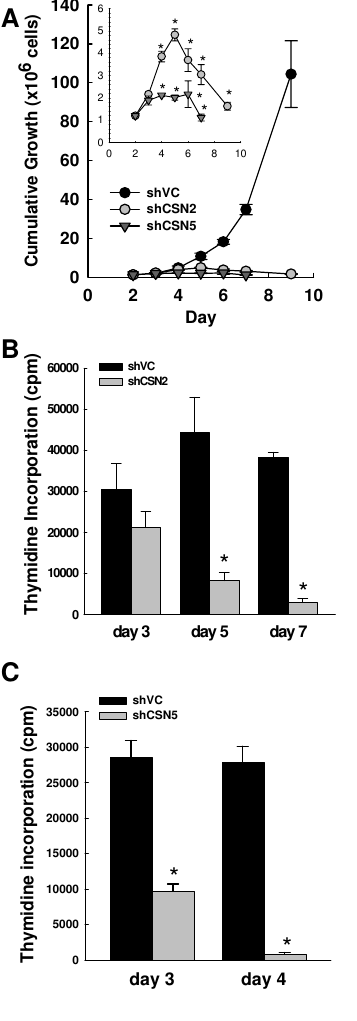
Figure 3 Both CSN2 and CSN5 knockdowns result in reduced cell growth . K562 cells were transiently co-transfected with HKK plasmid together with either shVC, shCSN2 or shCSN5 plasmid. HKK positive cells were sorted 24 hours post-transfection and cells re-cultured. (A) Cell counts were taken daily and the cumulative growth calculated. The cumu- lative growth of shCSN2 and shCSN5 cells is shown relative to shVC. The insert graph has a different Y scale to highlight the differences between shCSN2 and shCSN5 cumulative growth profiles. Data shown are the mean ± s.e.m. of n = 3. * indicates a significant difference to shVC cell growth with a p value of less than 0.05. (B) Thymidine incorporation in shCSN2 cells relative to shVC cells was measured day 3, 5 and 7 post transfection. Data shown are the mean ± s.e.m. of n = 3. (C) Thymidine incorporation in shCSN5 cells relative to shVC cells was measured day 3 and 4 post transfection. Data shown are the mean ± s.e.m. of n = 3. * indicates signif- icance with a p value of less than